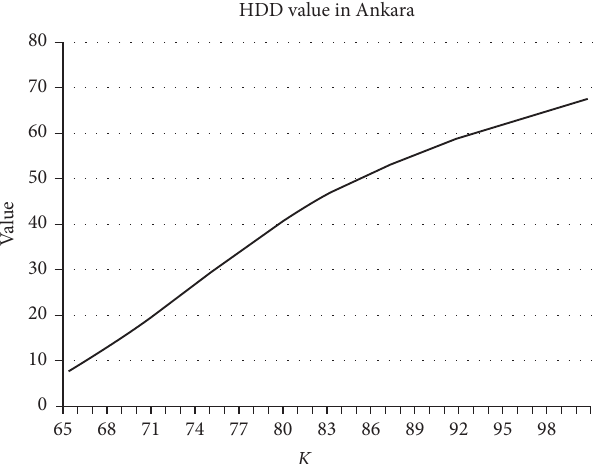
Figure 4: Estimated value of an HDD for